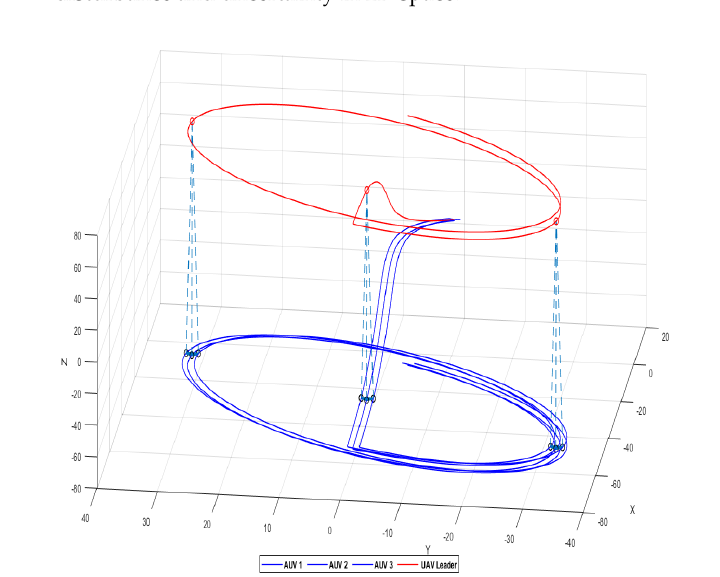
Figure 3. The formation control of three AUVs in triangle form with their UAVs leader without disturbance and uncertainty in 3D